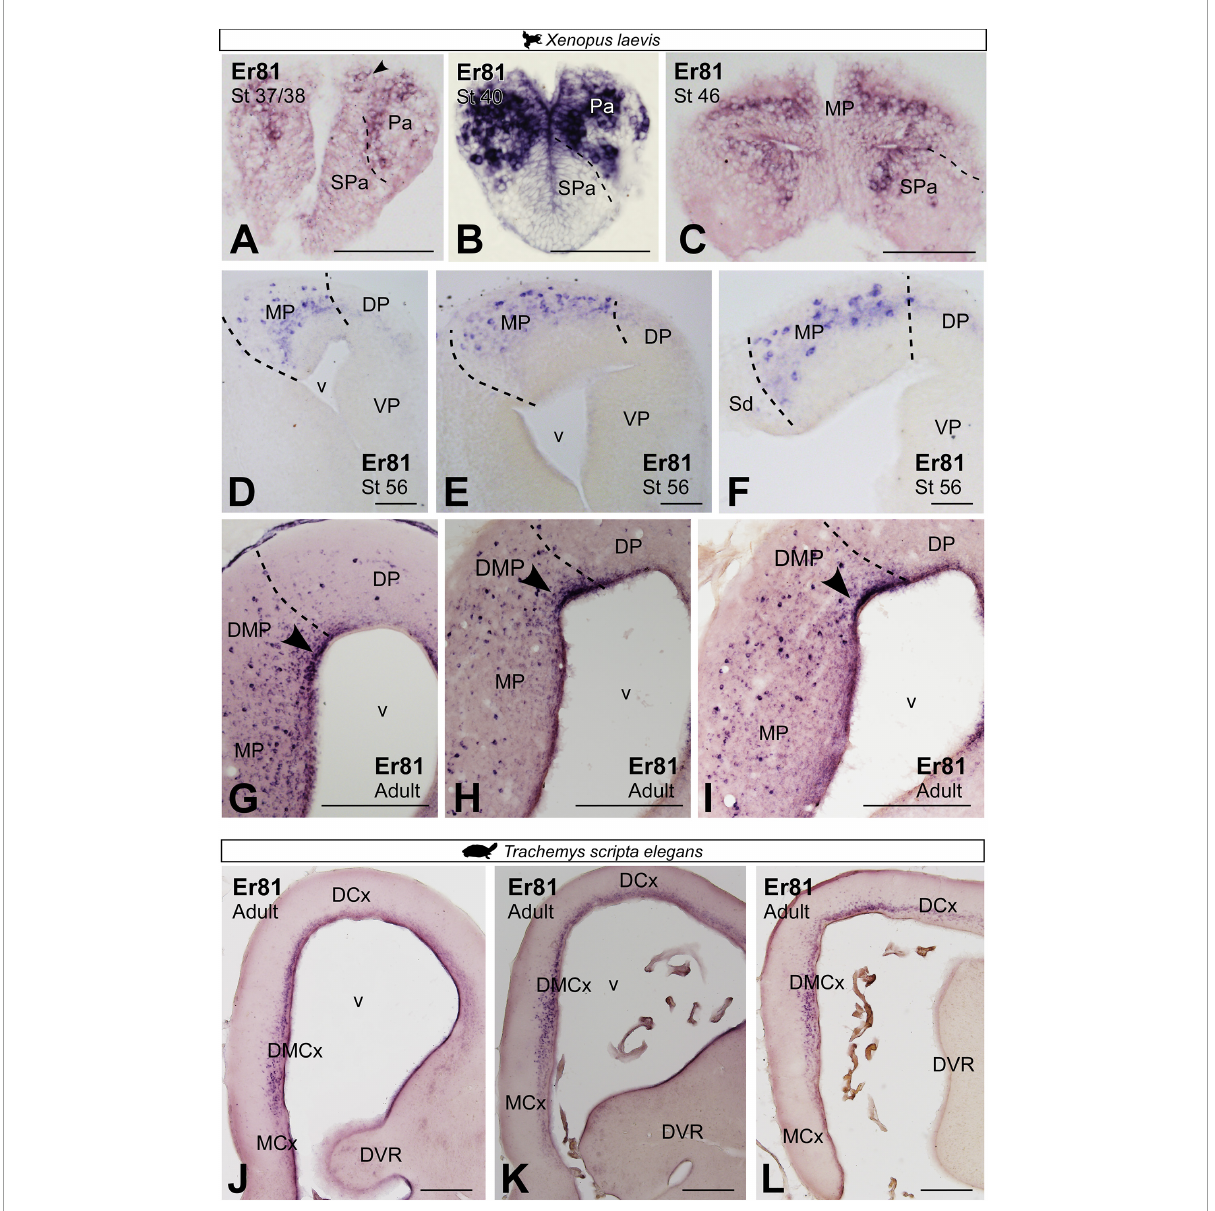
FIGURE8 Photomicrographs of transverse sections through the telencephalon of Xenopus laevis (A–I) and Trachemys scripta elegans (J–L) showing, from rostral to caudal levels, the Er81 expression at embryonic (A) , premetamorphic (B,C) and prometamorphic larval X. laevis stages (D–F) and adults (G–I) and adults Trachemys scripta elegans (J–L) . Filled arrowheads point to ventricle expressing cells. Scale bar in panels (A–F,J–L) = 200 µ m and (G–I) = 500 µ m. See the abbreviation